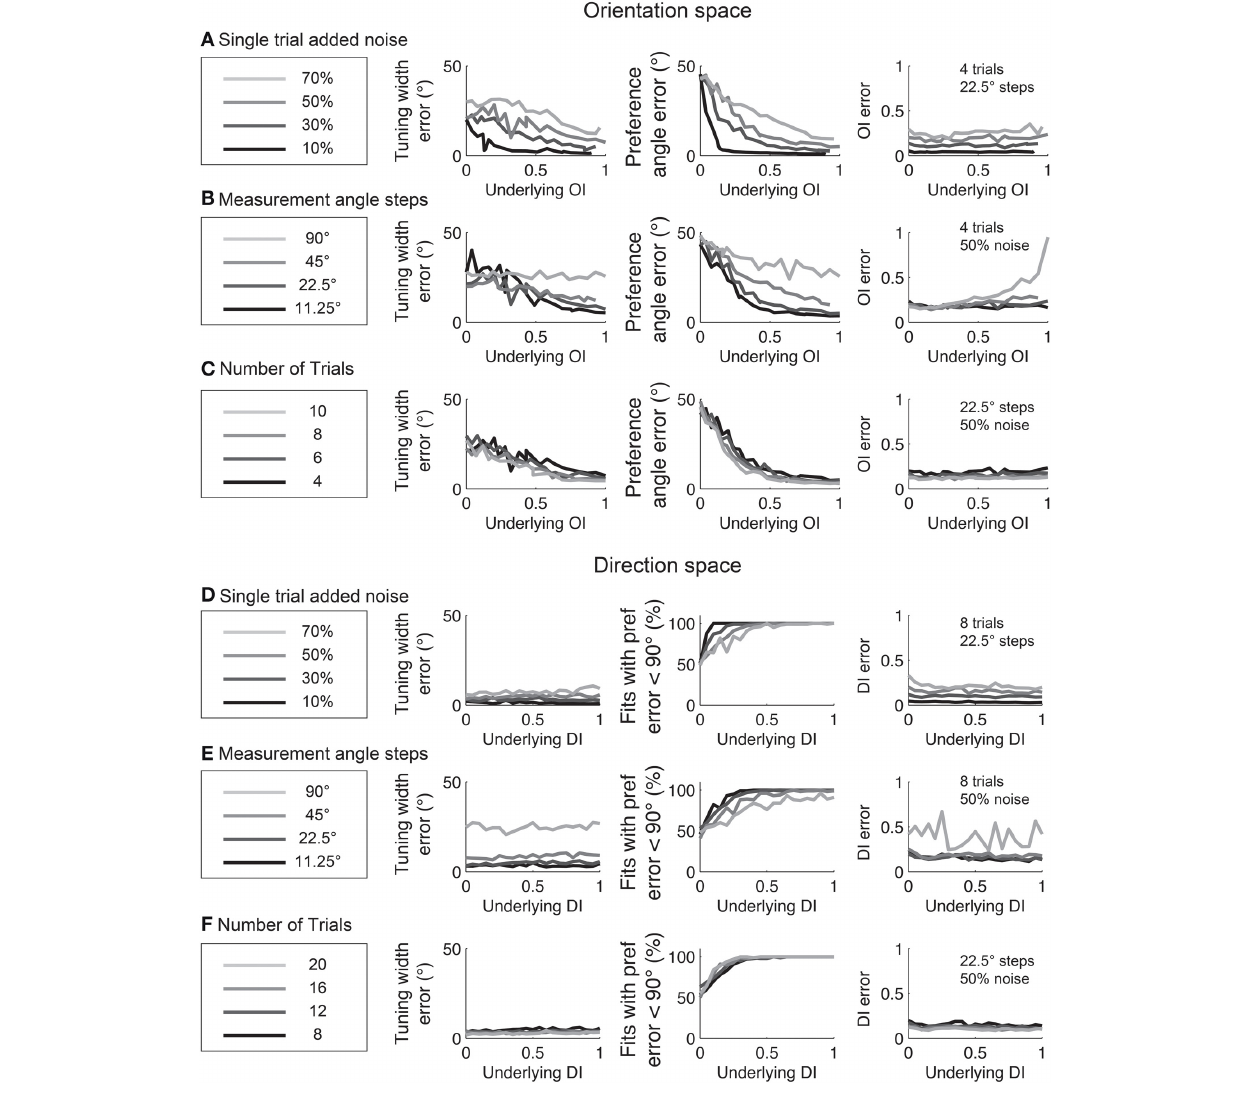
as a percentage of the maximum response rate to the preferred direction. (B,E) Dependence of error on number of angle steps. Additional angle steps offer a modest improvement in estimating the fit parameters. (C,F) Dependence of error on the number of trials. More trials offer modest improvements in average